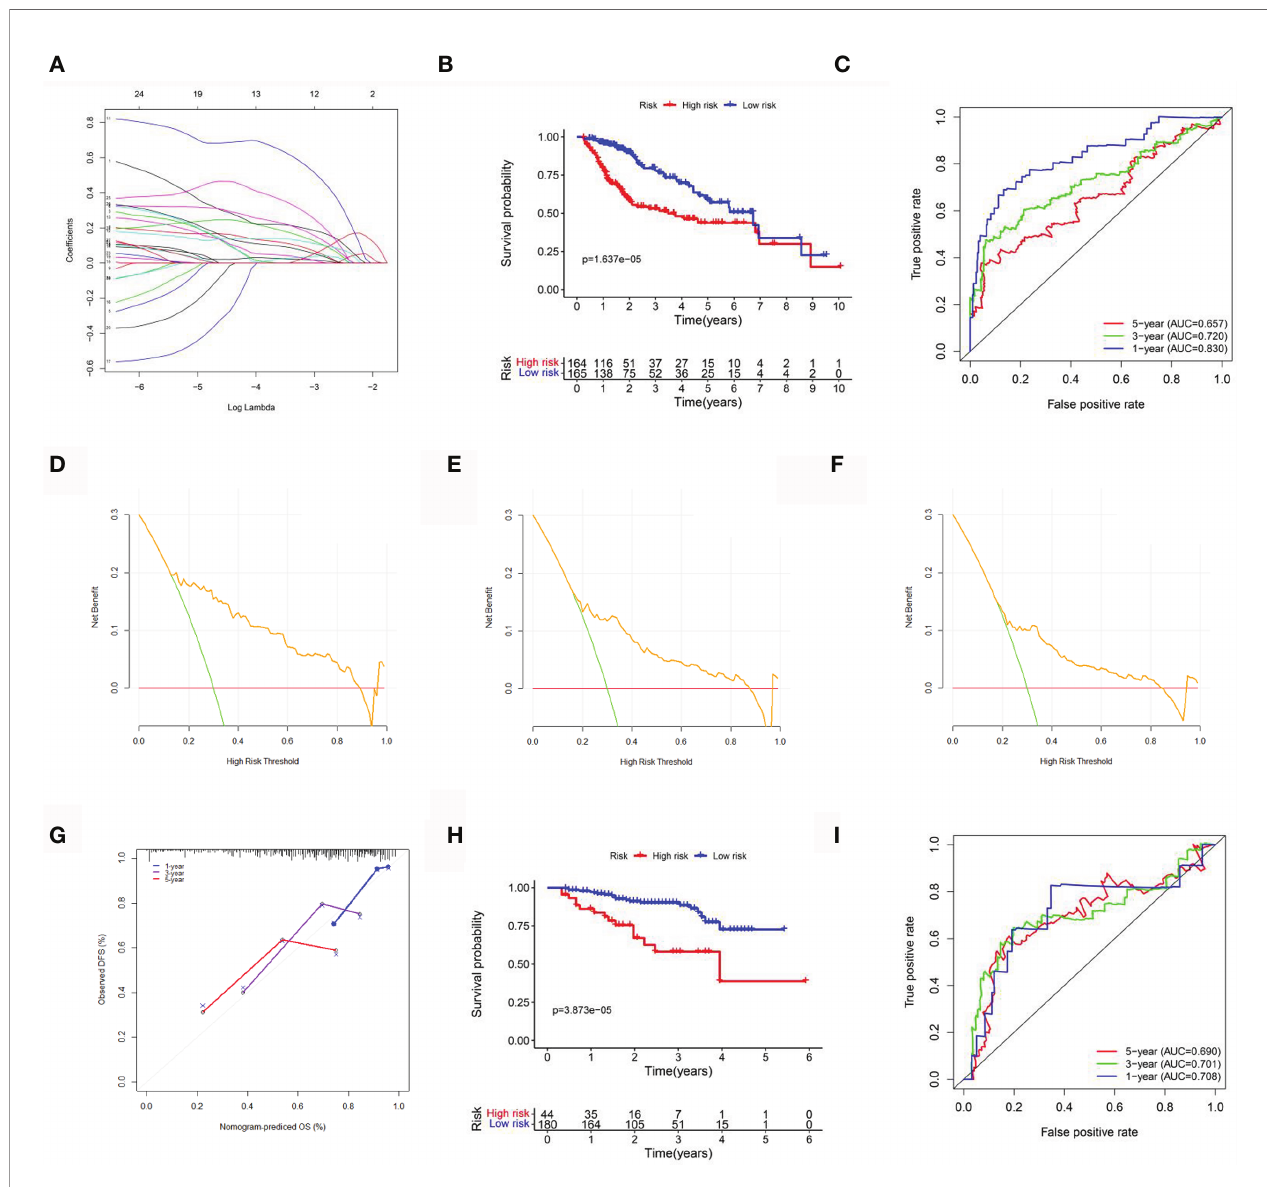
FIGURE 5 | Establishment and validation of the prognostic signal for HCC. (A) Lasso regression analysis to identify the characteristic value of the constructed diagnostic signal. (B) Survival analysis between the high-risk and low-risk groups. (C) The area under the ROC curve (AUC) of PIRs for 1-, 3-, and 5-year OS in the TCGA data set. (D – F) The DCA curve of PERs for 1, 3, and 5 years in the TCGA data set. (G) The calibration curve of PERs for 1, 3, and 5 years in the TCGA data set. (H) Survival analysis between the high-risk and low-risk groups in the ICGC-LIHC data set. (I) The AUC of PIRs for 1-, 3-, and 5-year OS in the TCGA data